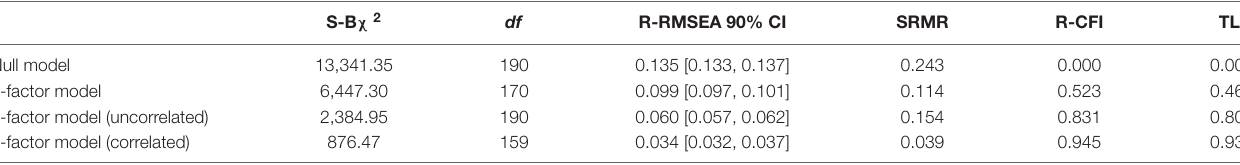
TABLE 2 | Goodness-of-fit indexes of the statistic models of the CSAS-P.